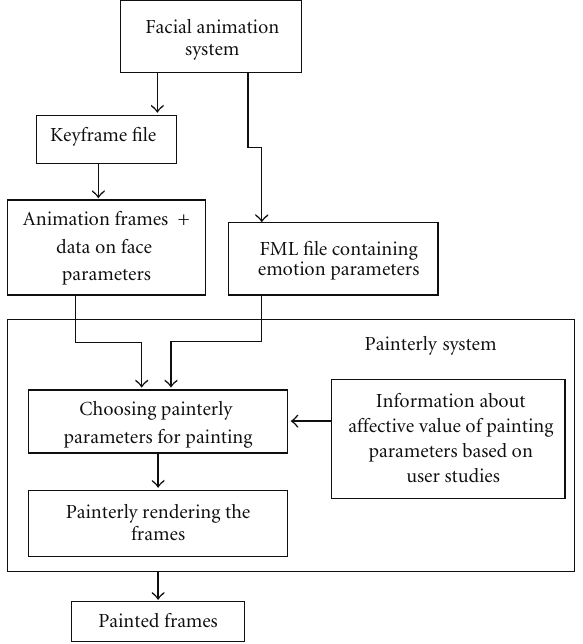
Figure 3: Integration diagram for painterly rendering based on the emotion information.